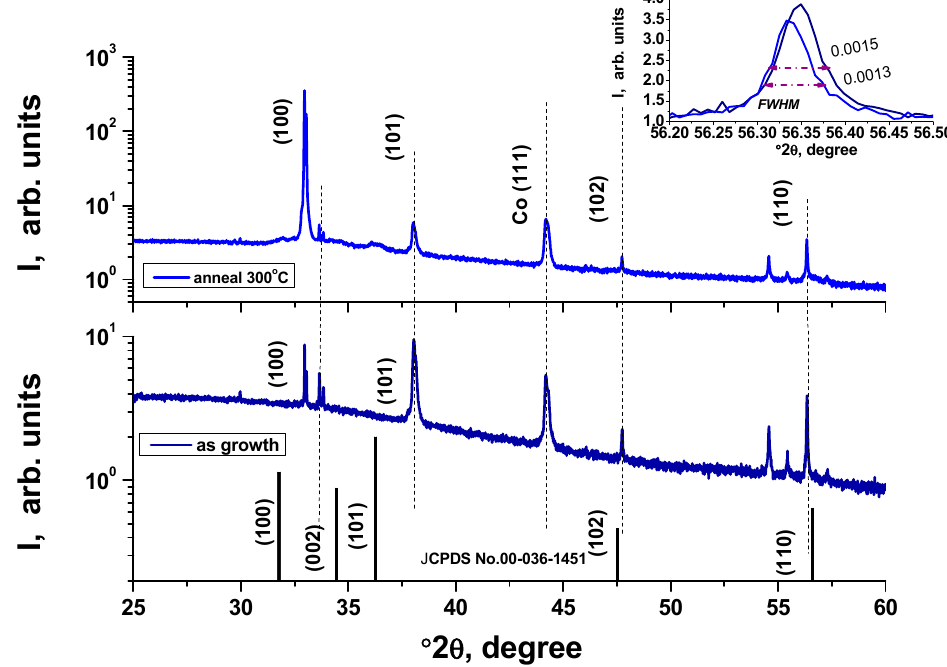
Figure 1. XRD diffractograms for thin layers of ZnO:Co grown in vacuum (on a silicon) at substrate temperature 30 °C, without annealing and annealed in air (at temperature 300 °C). JCPDS No. 00-036-1451 was also placed. In the inset, the peak width at half the maximum (FWHM) for the (110) peak is shown for both samples .